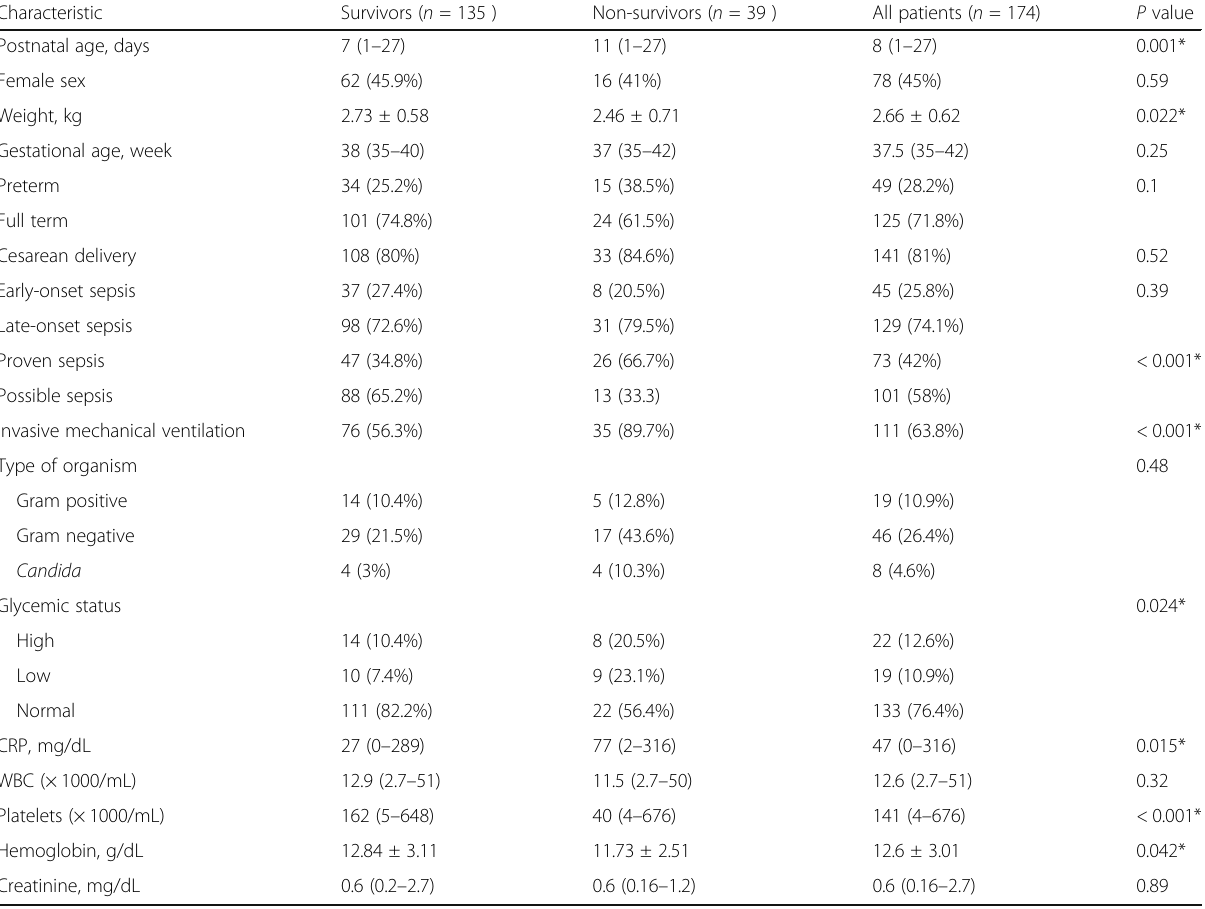
Table 1 Demographic, clinical, and laboratory characteristics of patients